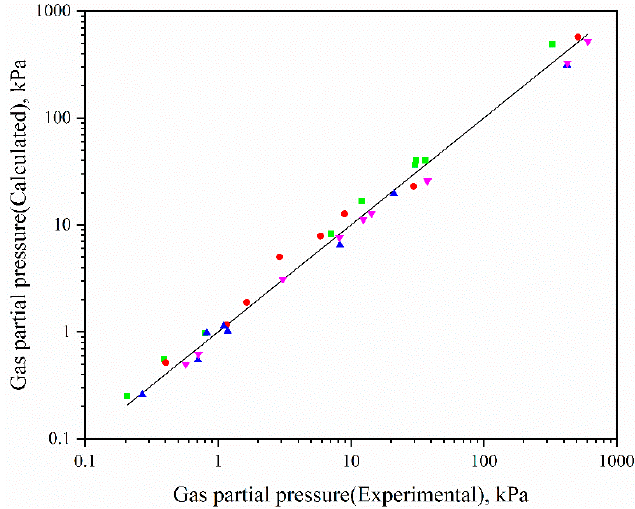
Figure 8. Parity plot for CH 3 SH partial pressure, experimental data vs. model predictions. CH 3 SH–